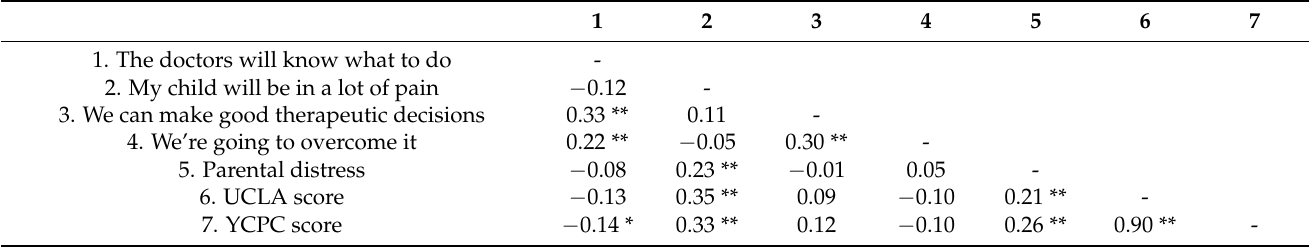
Table 4. Matching quality indices of the approximate model (N = 149).